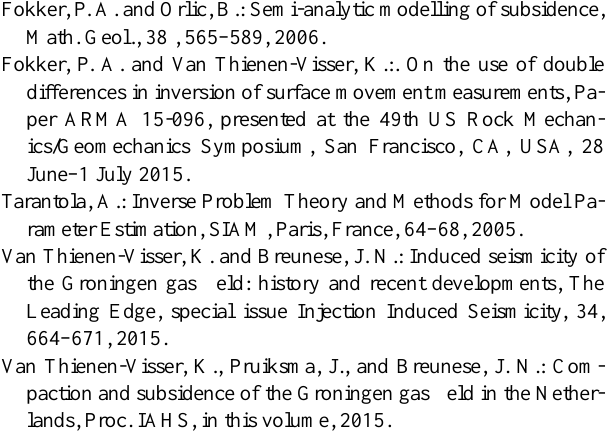
− d ) / ( G m − d ). Abso- 0 E